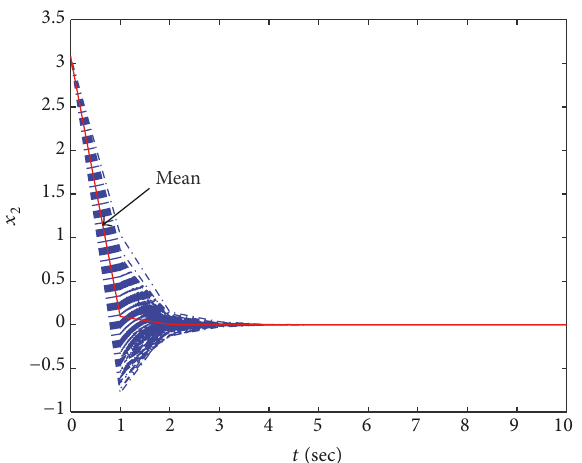
Figure 2: Trajectory of 𝑥 2 (𝑘) : the closed-loop system (28) without external